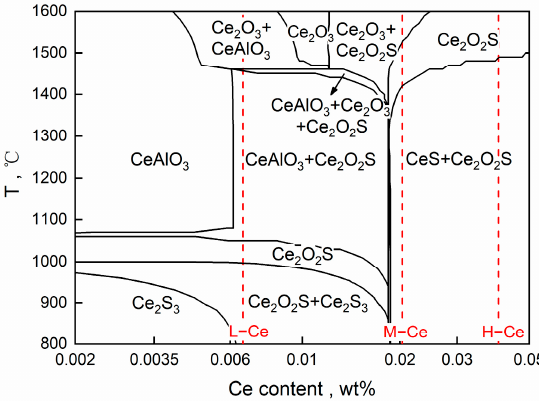
Figure 14. Simulation results of equilibrium precipitation of inclusions during ingot cooling